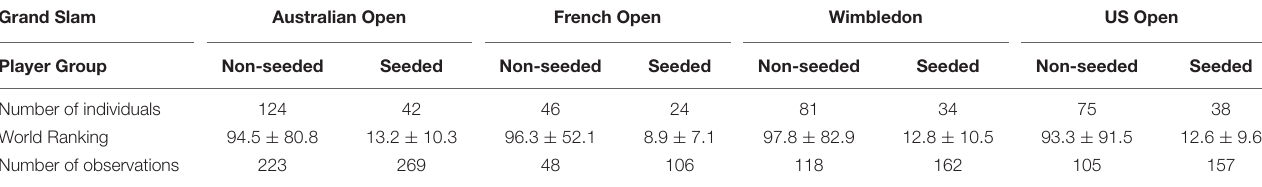
TABLE 1 | Distribution and ranking (mean ± SD) of sampled players from four Grand Slams. Grand Slam